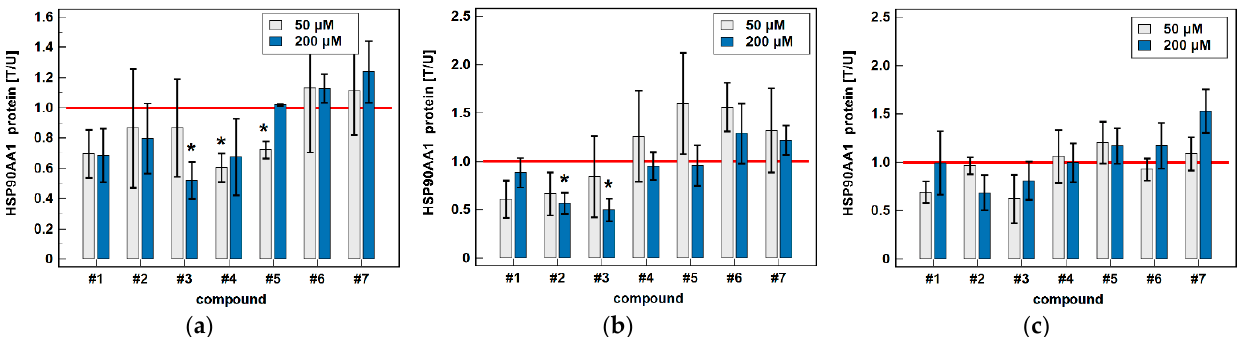
Figure 7. Effect of oxicams on HSP90AA1 protein expression in colorectal adenocarcinoma cell lines: ( a ) Caco-2; ( b ) HCT 116; ( c ) HT-29. Data presented as means±SEM ( n = 3) of normalized expression in treated against untreated cells [T/U] and analyzed using t -test for one mean. Statistical significance ( p < 0.05) is indicated by asterisks (*) and protein expression in control (untreated) cells is indicated by horizontal red solid line. Cells were treated with 50 µM or 200 µM oxicams for 48 h. Compound #6 denotes piroxicam and #7—meloxicam.